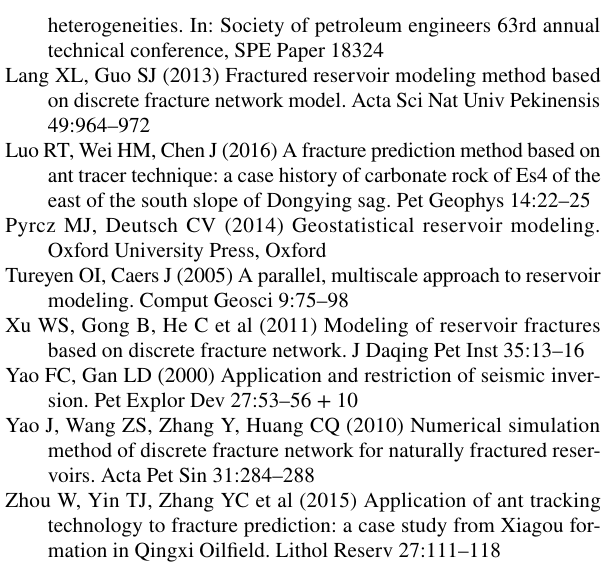
Fig. 9 Prediction of fractures using dynamic data in Maxi Oilfield. a Fitting map of waterflooding front of Well gs4-3. b Fractures near Well gs4-3. c Water and oil production curve Well gs4-4-1. d Water and oil production curve Well